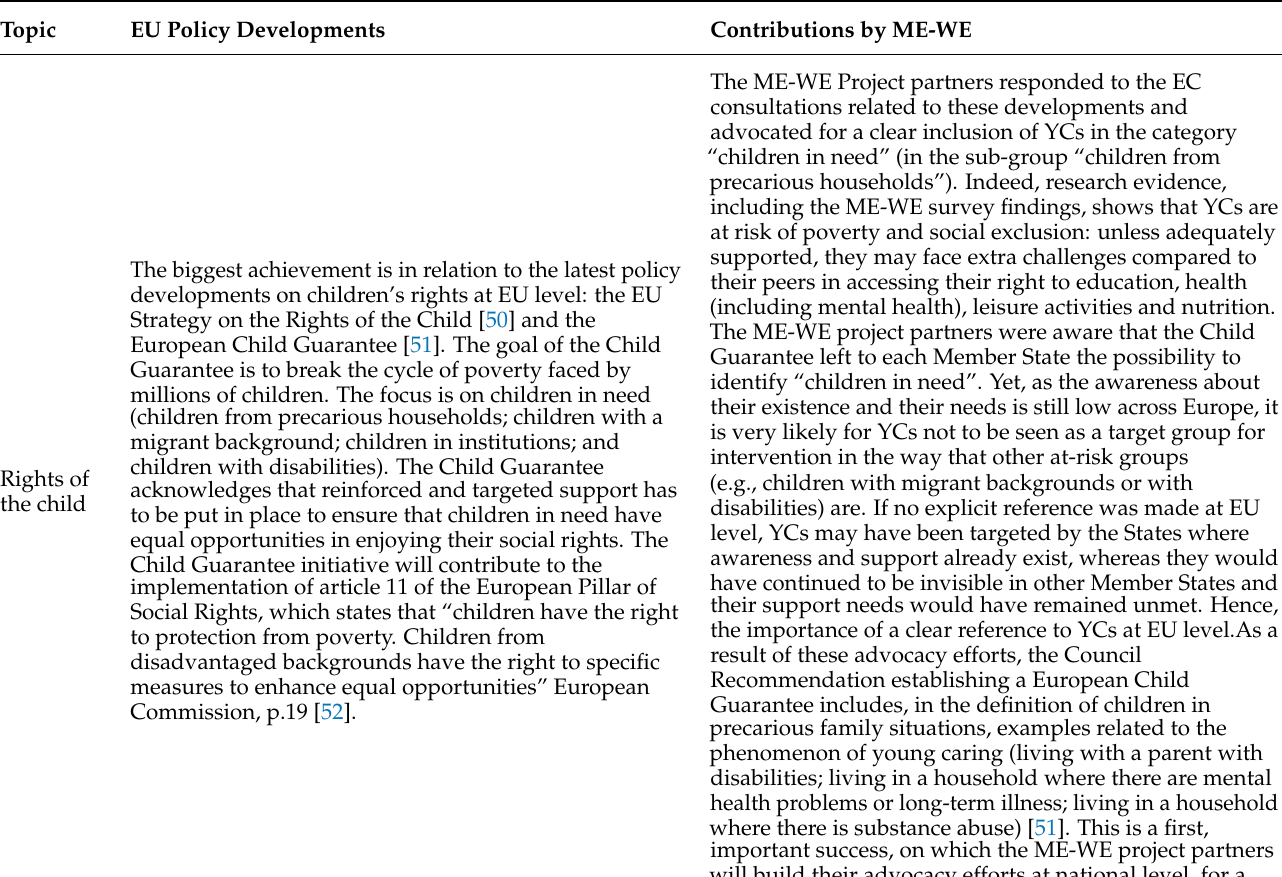
Table 11. EU policy developments and contributions by